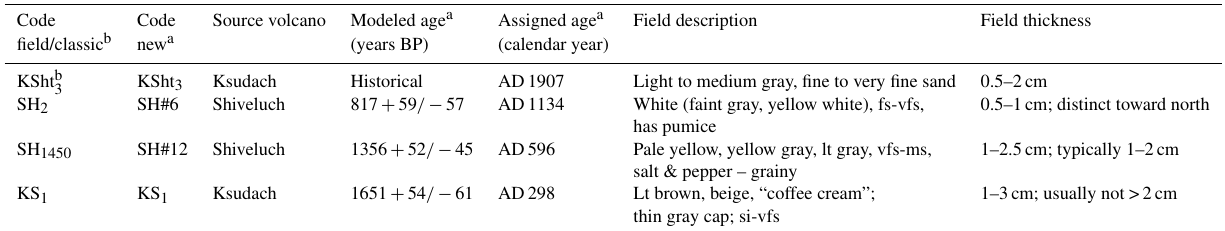
Table 2. Marker tephra layers <2000 years old in shoreline profile sections, southern Kamchatsky Bay a .